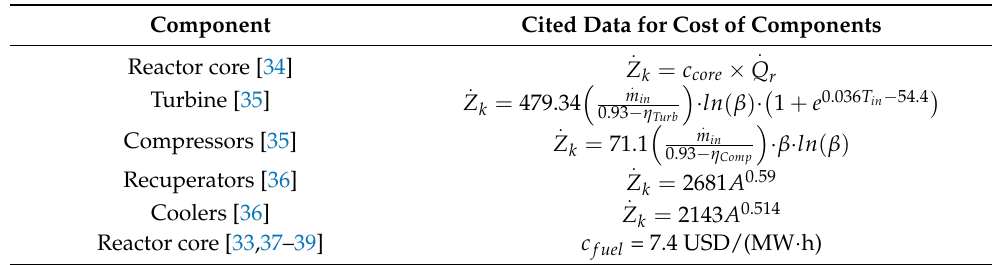
Table 1. Cited data for cost of